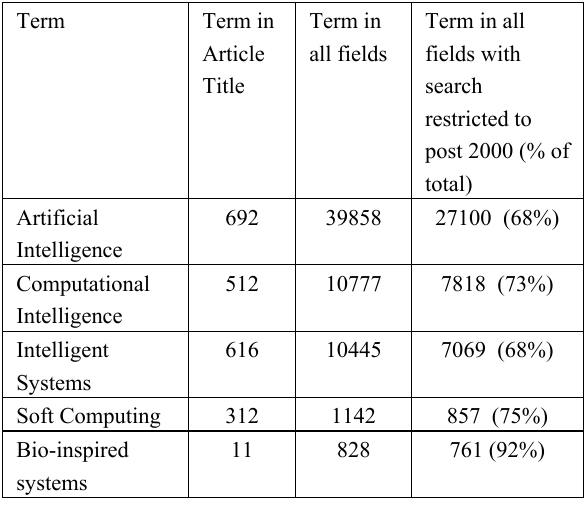
Table 1: Summary of searches using IEEE Xplore